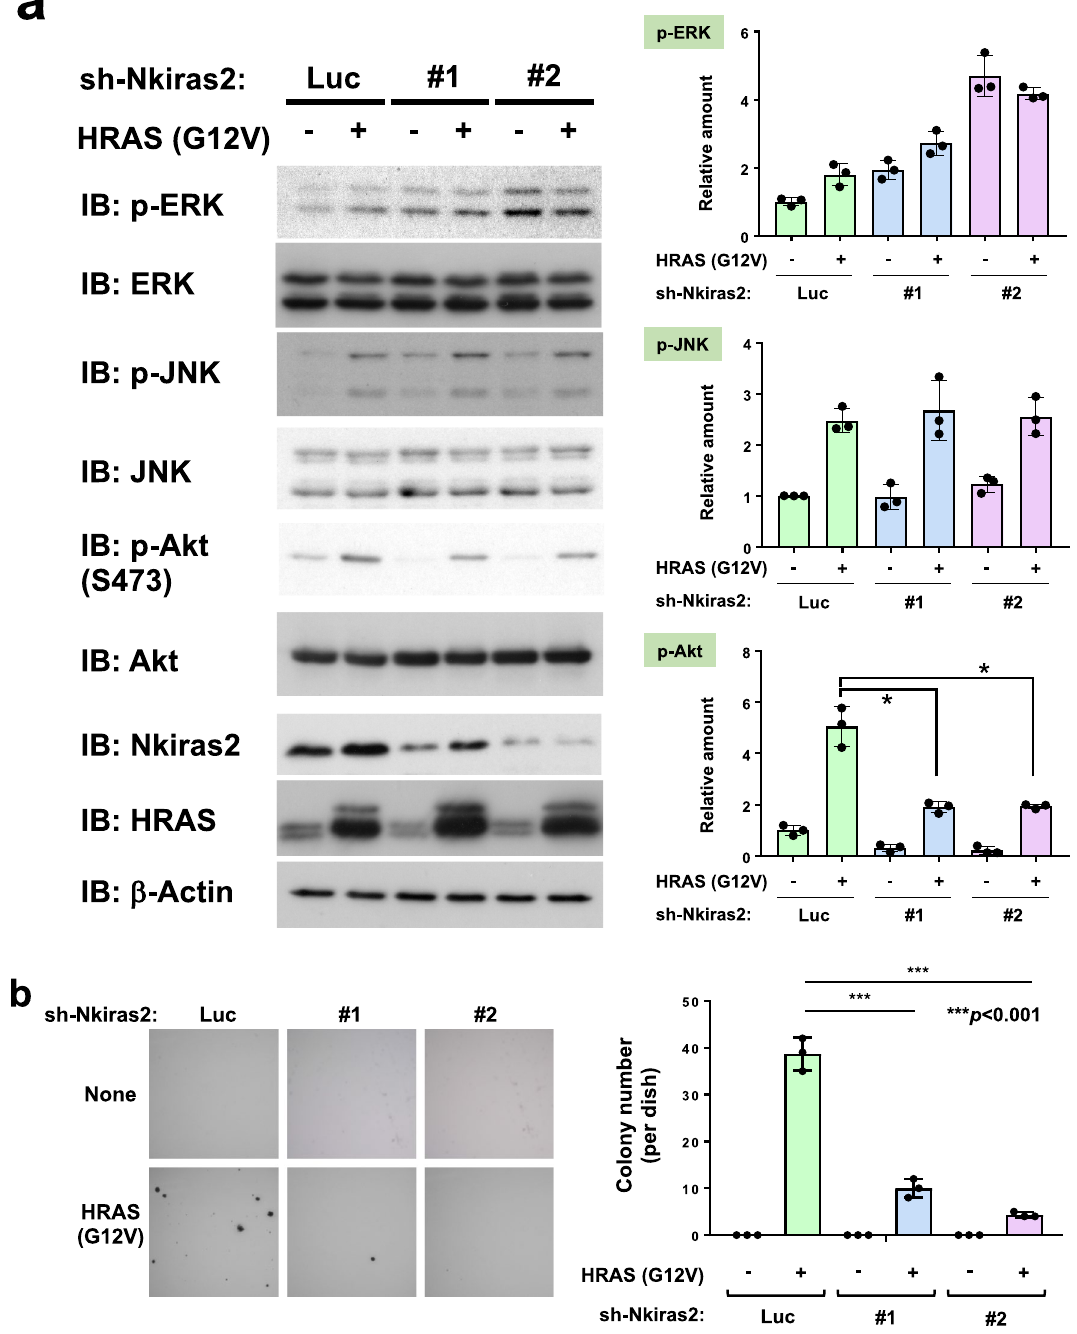
Figure 5. Effect of knockdown of Nkiras2 on HRAS (G12V)-provoked cellular transformation. ( a ) NIH-3T3 cells were infected with the indicated combination of retroviruses, and their lysates were utilized for immunoblotting analysis. To decrease Nkiras2 expression, two types of retroviruses harboring sh-RNA against murine Nkiras2 (called as sh-Nkiras2#1 and #2, also indicated as #1 and #2, respectively) were used. As control knockdown, retrovirus including sh-luciferase (sh-Luc; described as Luc) was utilized. The knockdown efficiency was examined using immunoblotting analysis. The effects of Nkiras2 knockdown on HRAS (G12V)- induced phosphorylation of ERK, JNK, and Akt are shown. As an internal control, the total amounts of ERK, JNK, and Akt are shown. The intensities of protein phosphorylation were shown in the graphs. ( b ) The infected NIH-3T3 cells as in ( a ) were utilized for a soft agar colony formation assay. The number of colonies is shown in the graph. All experiments were performed individually three times, and representative data shown in the graph. The graph shows means with the error bars indicating S.D. (n = 3), and * and ***indicates p < 0.01 and 0.001,